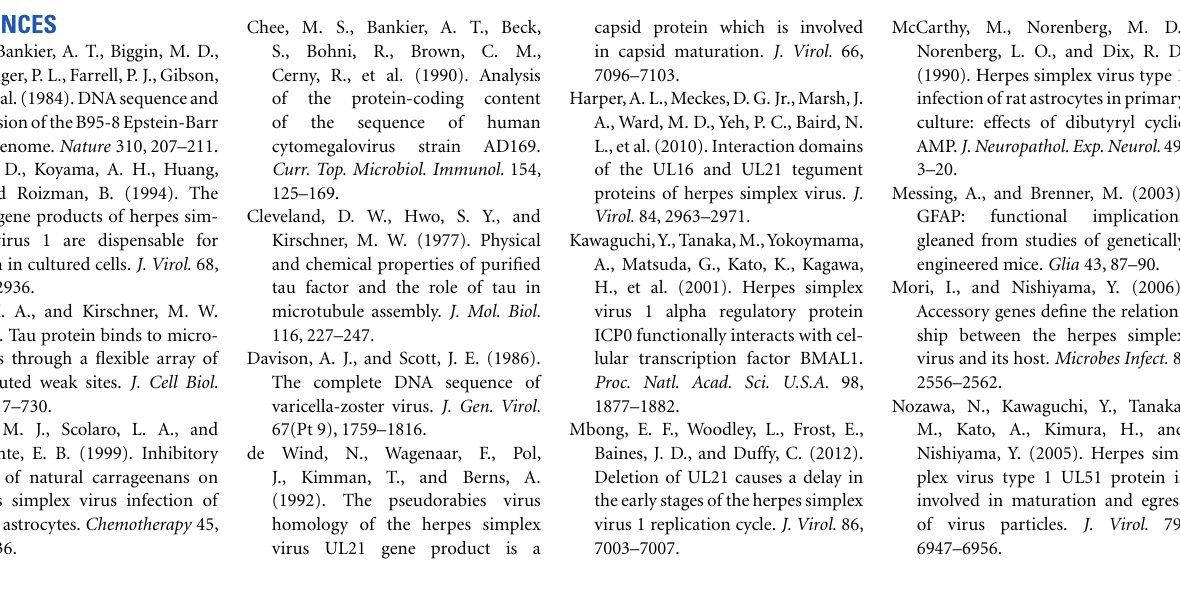
FIGURE 4 | Distribution of candidate proteins interacting with UL21 in glial cells. A172 cells were infected with wild-type HSV-1 (wt) or UL21D at an MOI of 3.The cells were fixed at 12 or 18h post-infection, reacted with anti- α -1-actinin, -GFAP, -GPR56, -NEFL, or